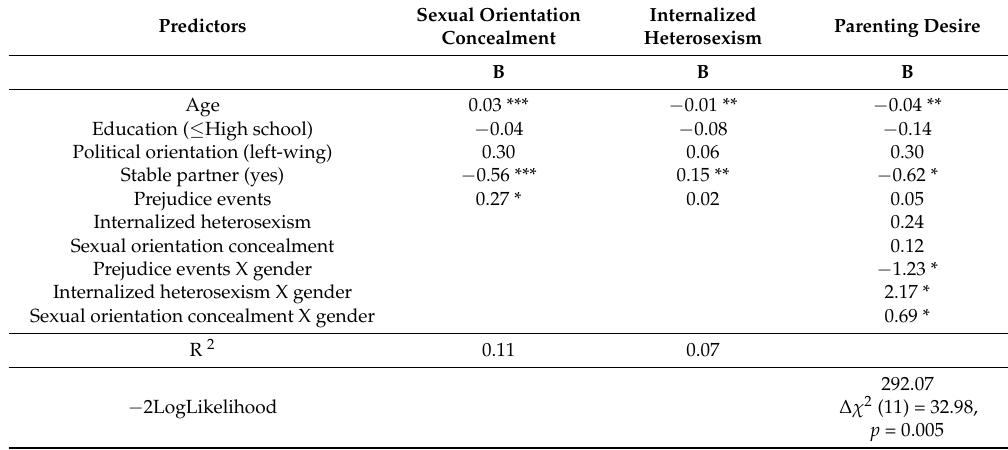
Table 3. Test of the moderated mediation effect of prejudice events on parenting desire through sexual orientation concealment and internalized heterosexism. Sexual Orientation Predictors